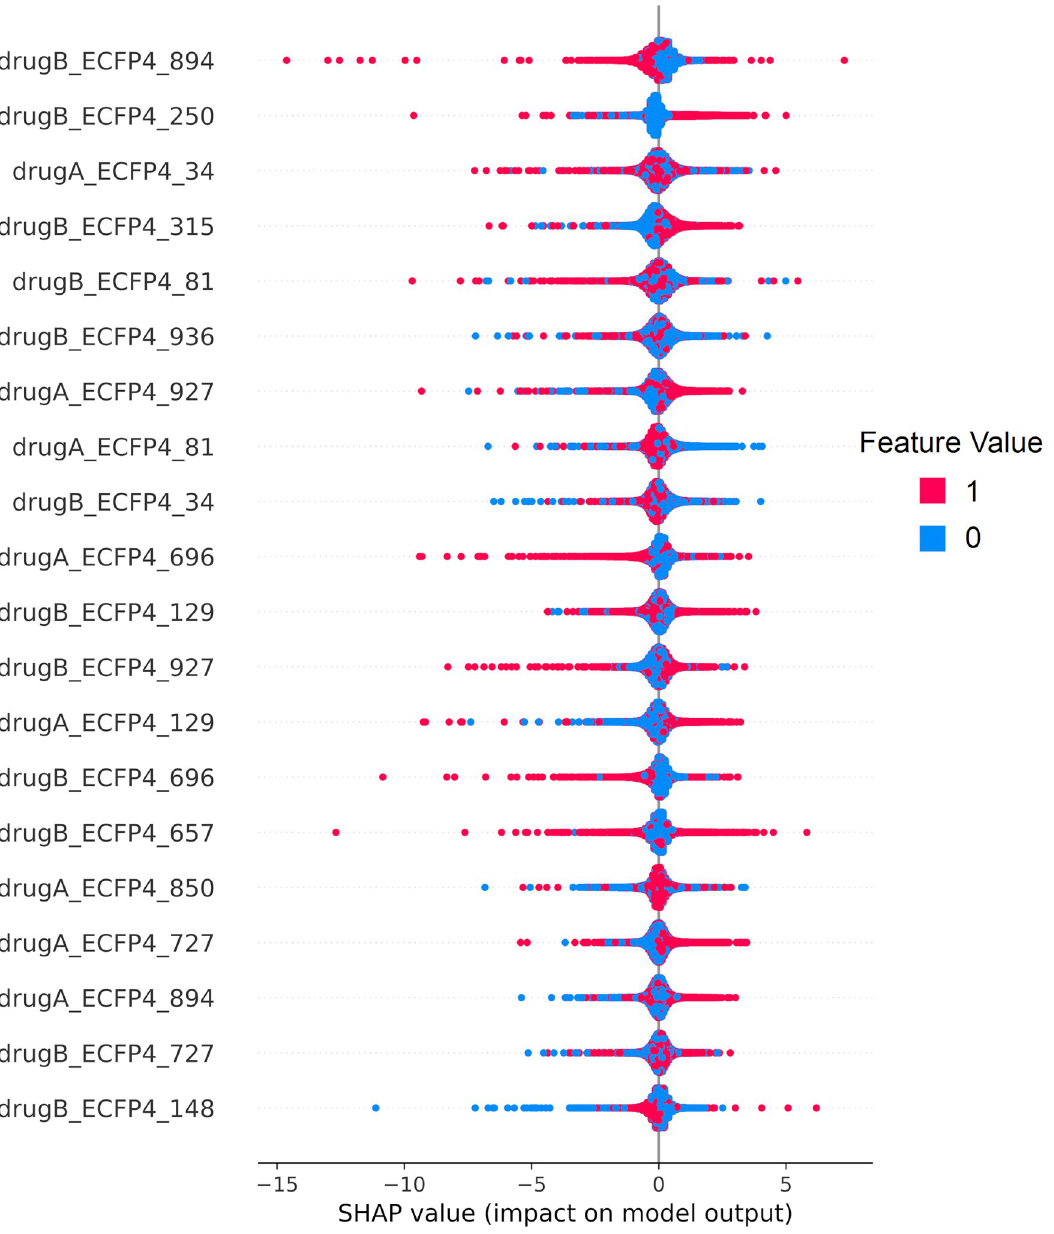
Fig 3. Top 20 most important features, ranked by mean absolute SHAP